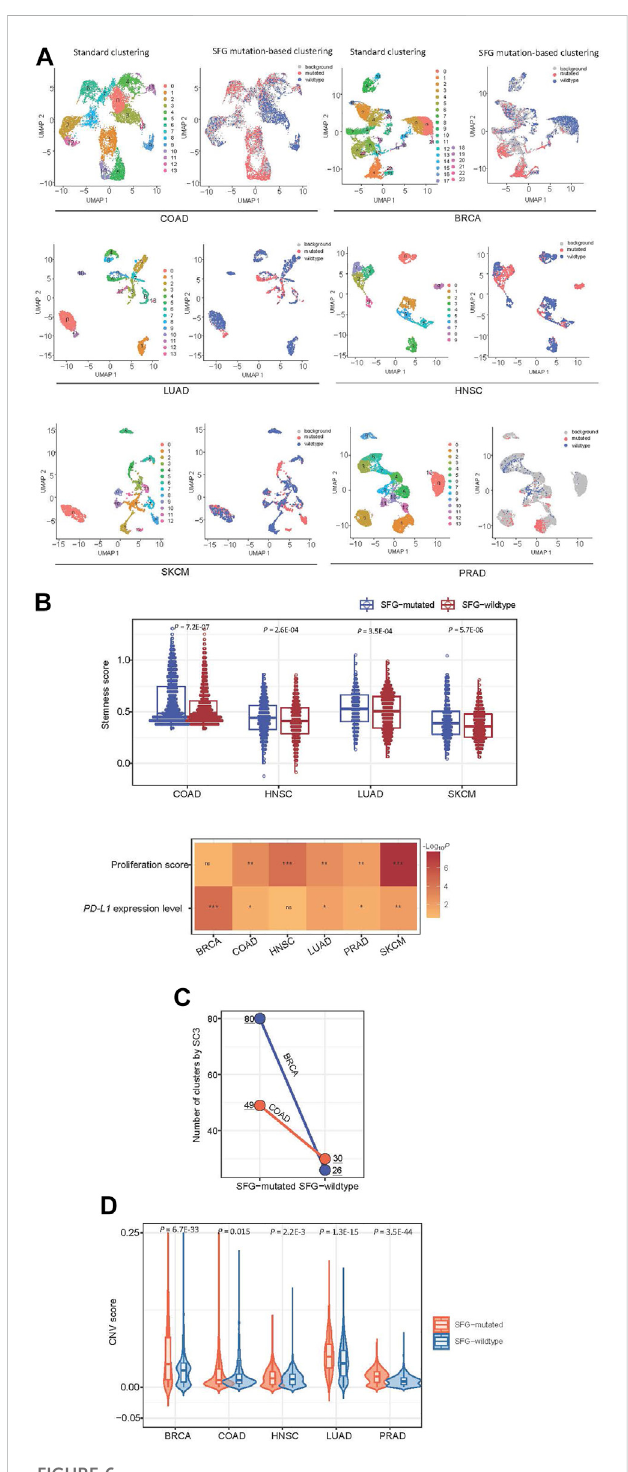
FIGURE 6 Exploration of SFG mutations in cancer single cells. (A) Identi fi cation of subpopulations of cancer single cells with phenotypes of SFG mutations and SFGwildtypeinsixsingle-celltranscriptomesbytheScissoralgorithm(Sunetal., 2022). (B) The SFG-mutated cancer cell subpopulation has signi fi cantly higherscoresofstemnessandproliferationandhigher PD-L1